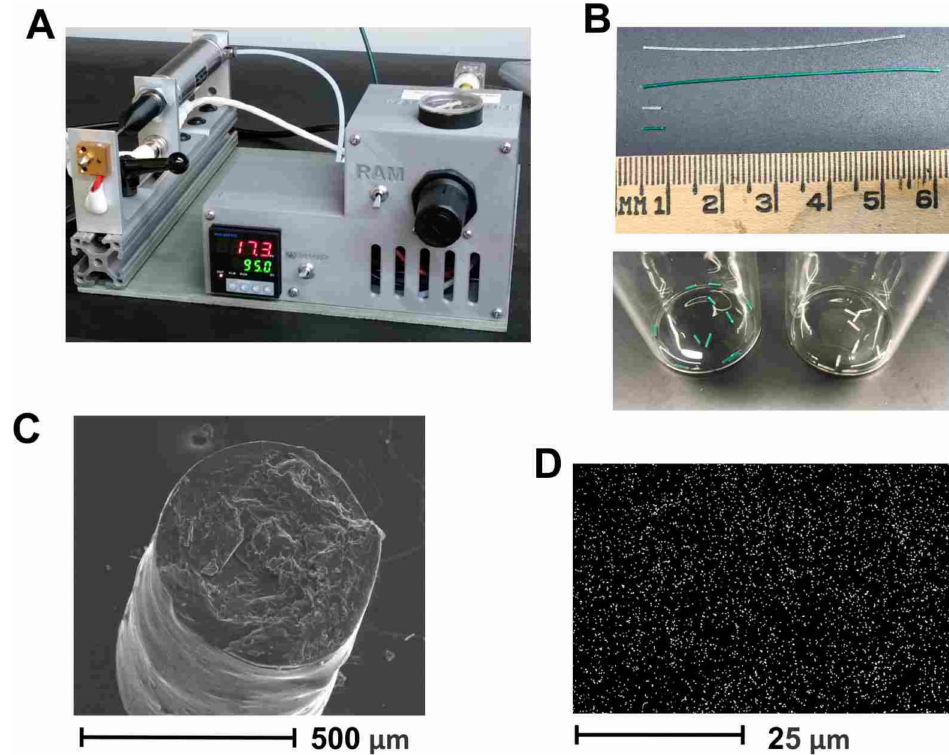
Figure 2. The preparation and characterization of melt-extruded PLGA implants. ( A ) Equipment for the melt processing of polymer materials. ( B ) PLGA implants produced by melt extrusion. The long implant bar produced directly from the device is shown at the top, with the short sections ready for implantation shown underneath. The photograph shows a metric ruler. The white bars are plain PLGA + Q β -HPV, and the green ones are FITC-PLGA + Cy5-Q β . ( C ) SEM image showing a cross-section of the PLGA implant loaded with Q β -HPV. ( D ) The EDX spectrum sulfur K-series emission signal (SK series) map of the PLGA implant loaded with Q β